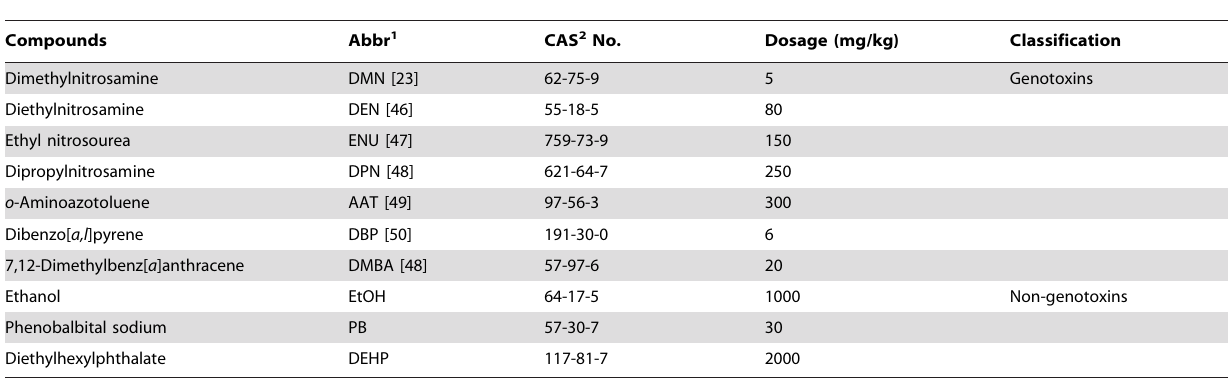
Table 1. Model compounds selected in the in vivo microarray study.